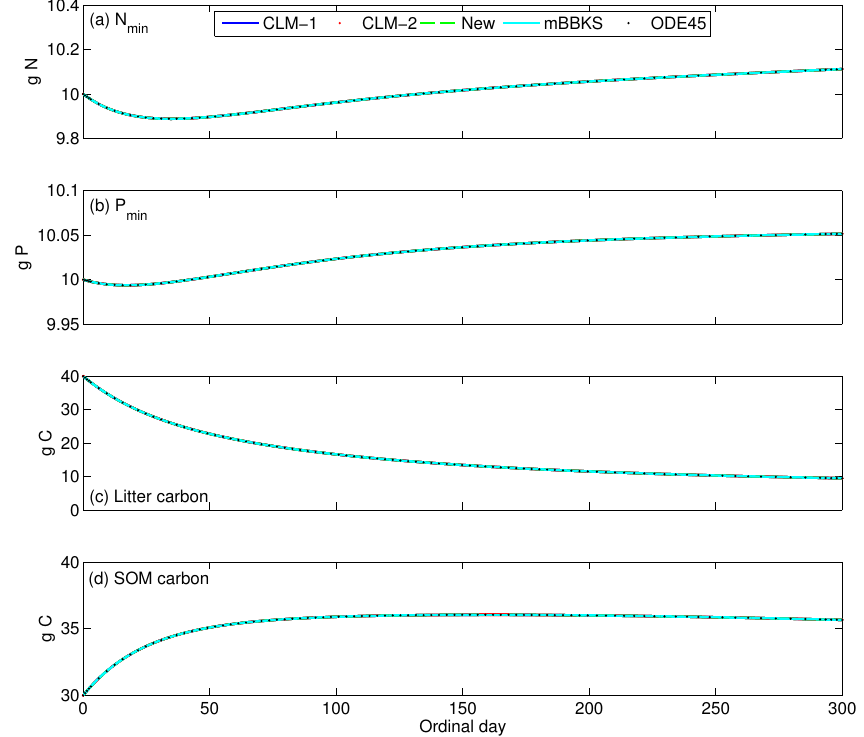
Figure 1. Simulated decomposition dynamics for Case 1 in Table 3. In all panels, all results overlap each other.